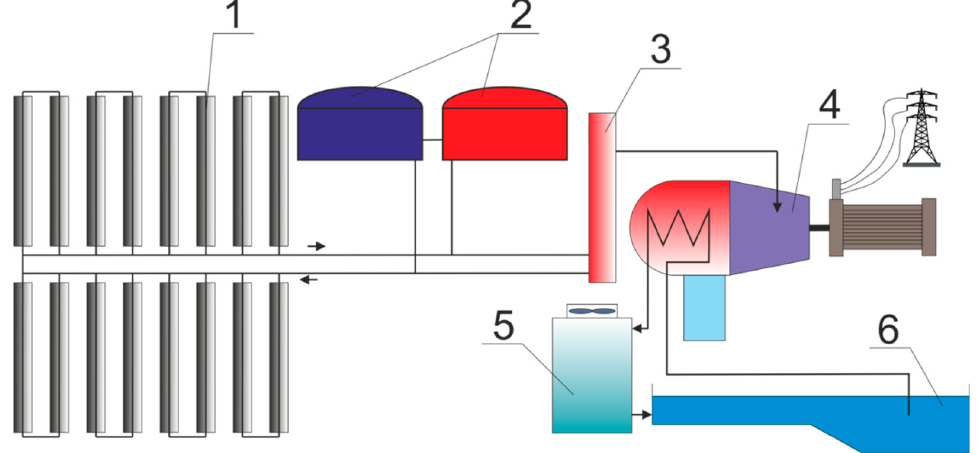
Figure 2. Simplified diagram of a thermal power plant with parabolic solar collectors: 1 —parabolic solar collectors, 2 —heat storage tanks, 3 —steam generation system, 4 —steam turbine, 5 —cooling tower, 6 —water storage reservoirs. Table 1. Description of the elements of the collector field in the Solar Thermal Power Station of te south of Spain.